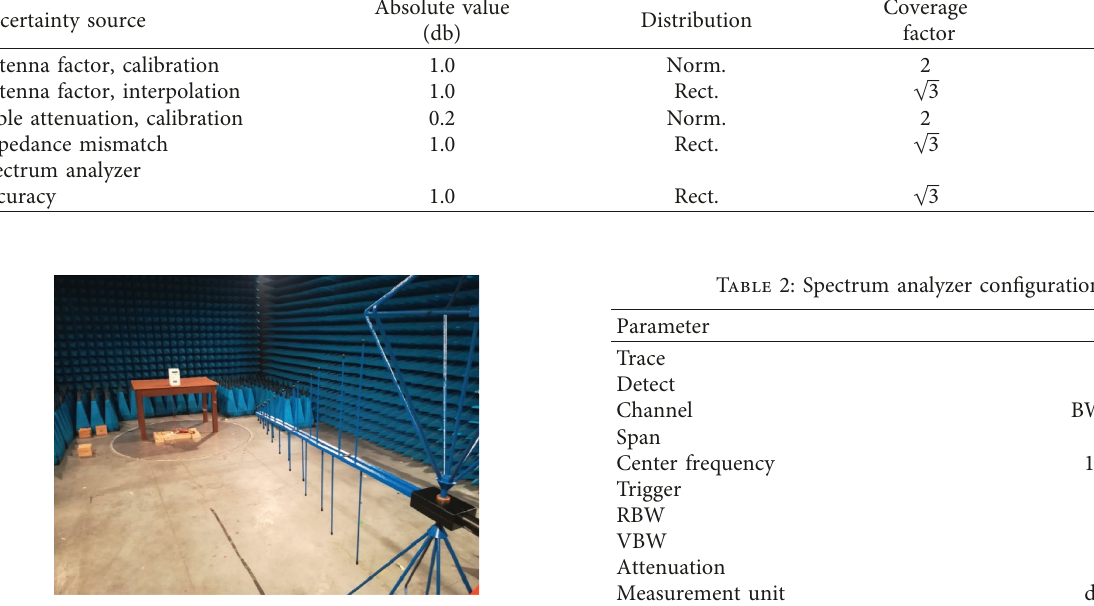
Figure 8: Test setup in the semianechoic room.